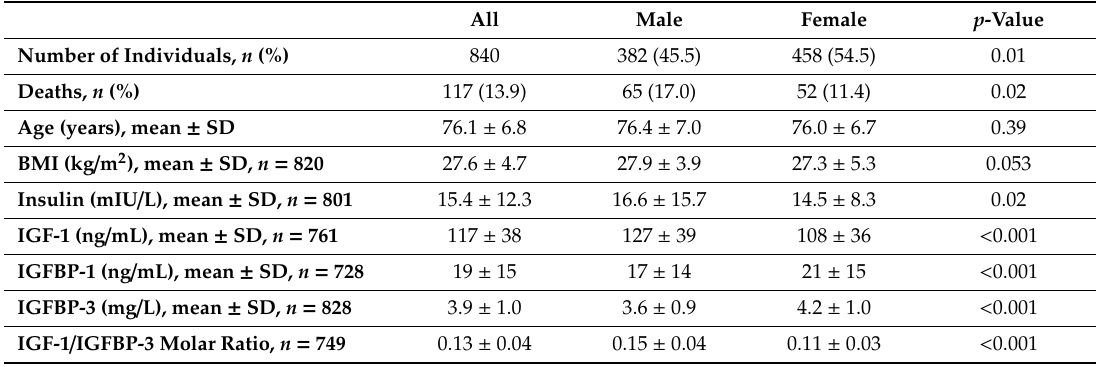
Table 1. Baseline characteristics of study cohort. All p -values are for comparisons between males and females. All Male